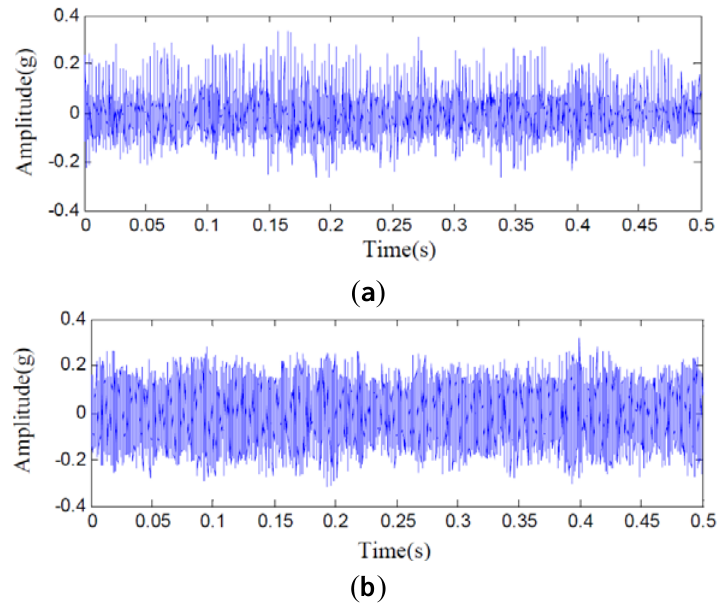
Figure 26. Typical raw data samples of experimental planetary gearbox in normal condition ( a ) and fault condition ( b